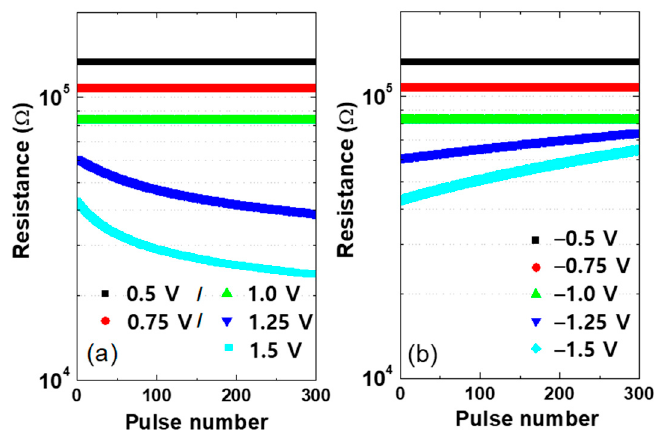
Figure 5. Resistance change of a memristor according to the ( a ) positive voltage and ( b ) negative voltage applied.